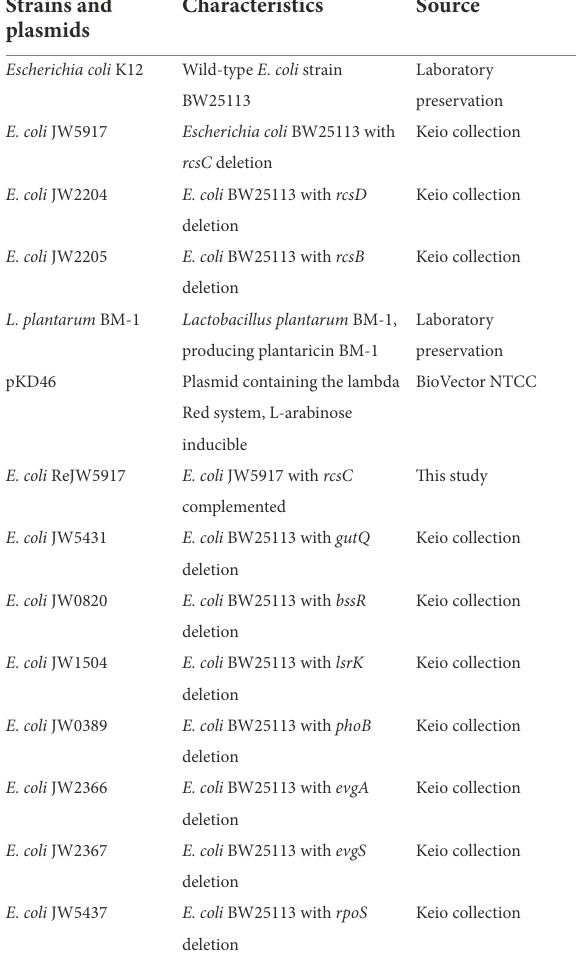
TABLE 1 Strains used in this